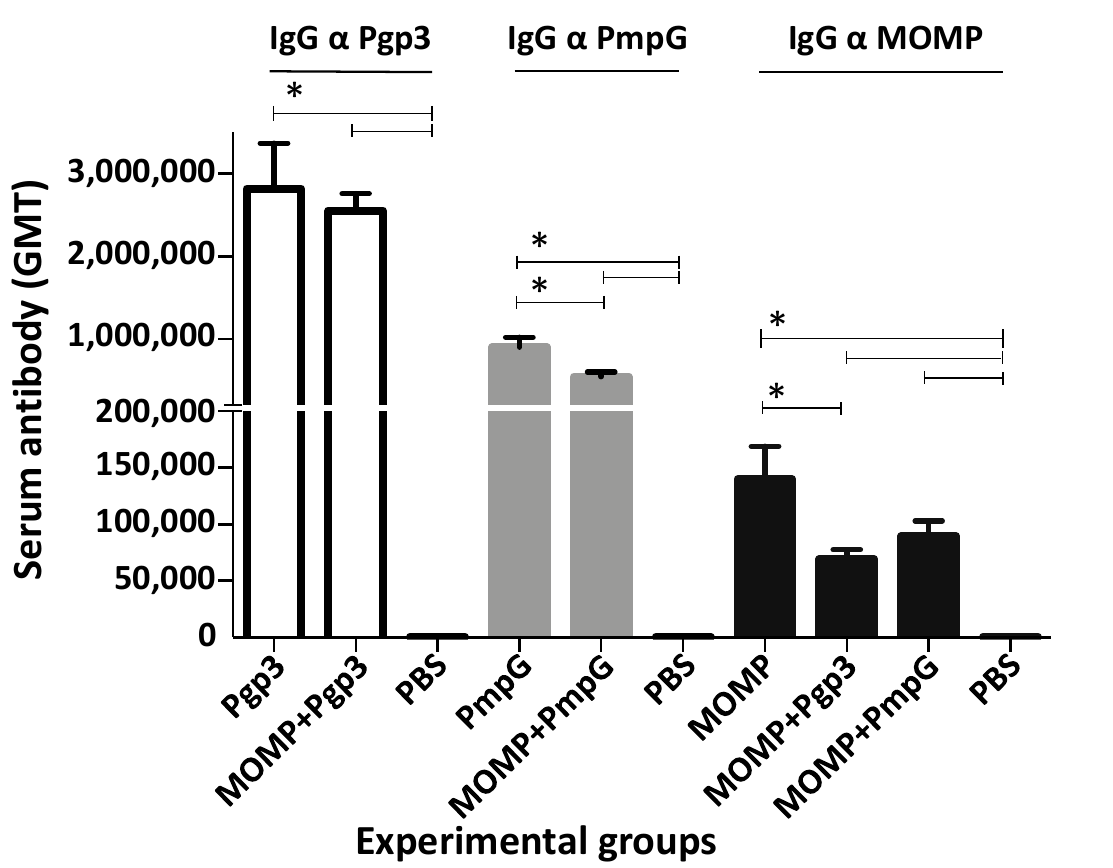
Figure 3. Vaccine-induced serum IgG antibody responses (GMT ± SE) against MOMP, PmpG, or